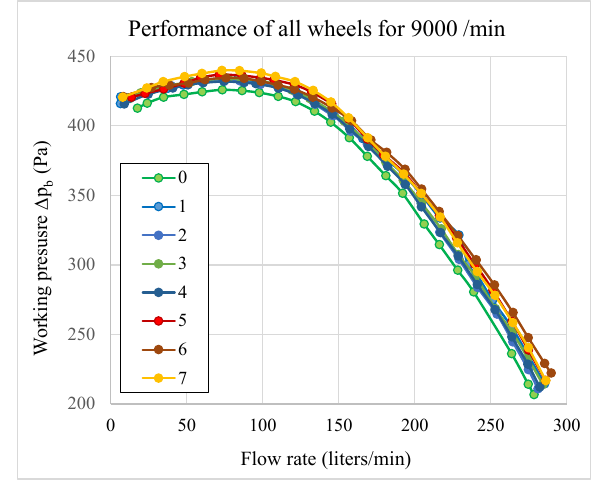
Fig. 8 Fan output for plastic and seven printed wheels for engine speed 9000 /min.